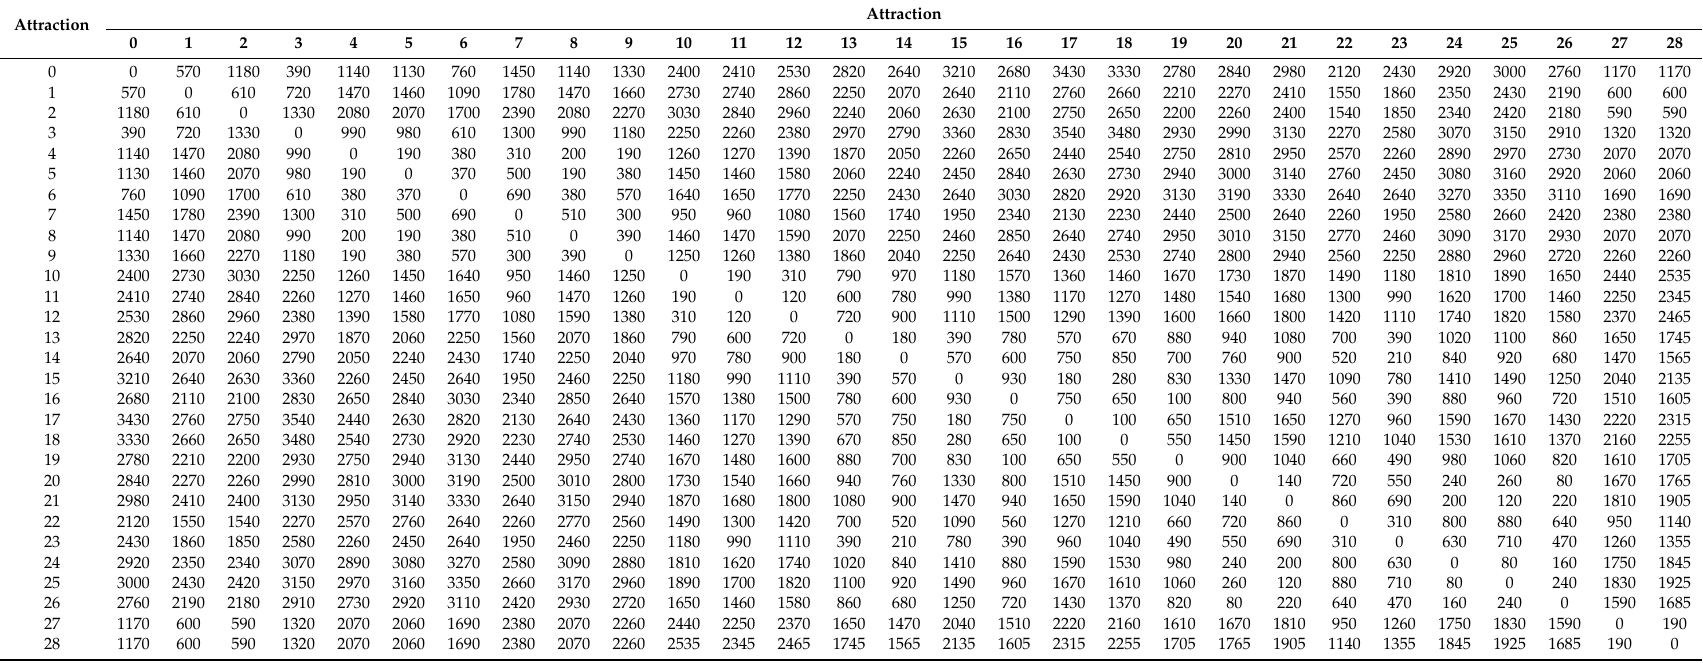
Table 1. Shortest distances among 28 attractions at Tokyo Disney Sea